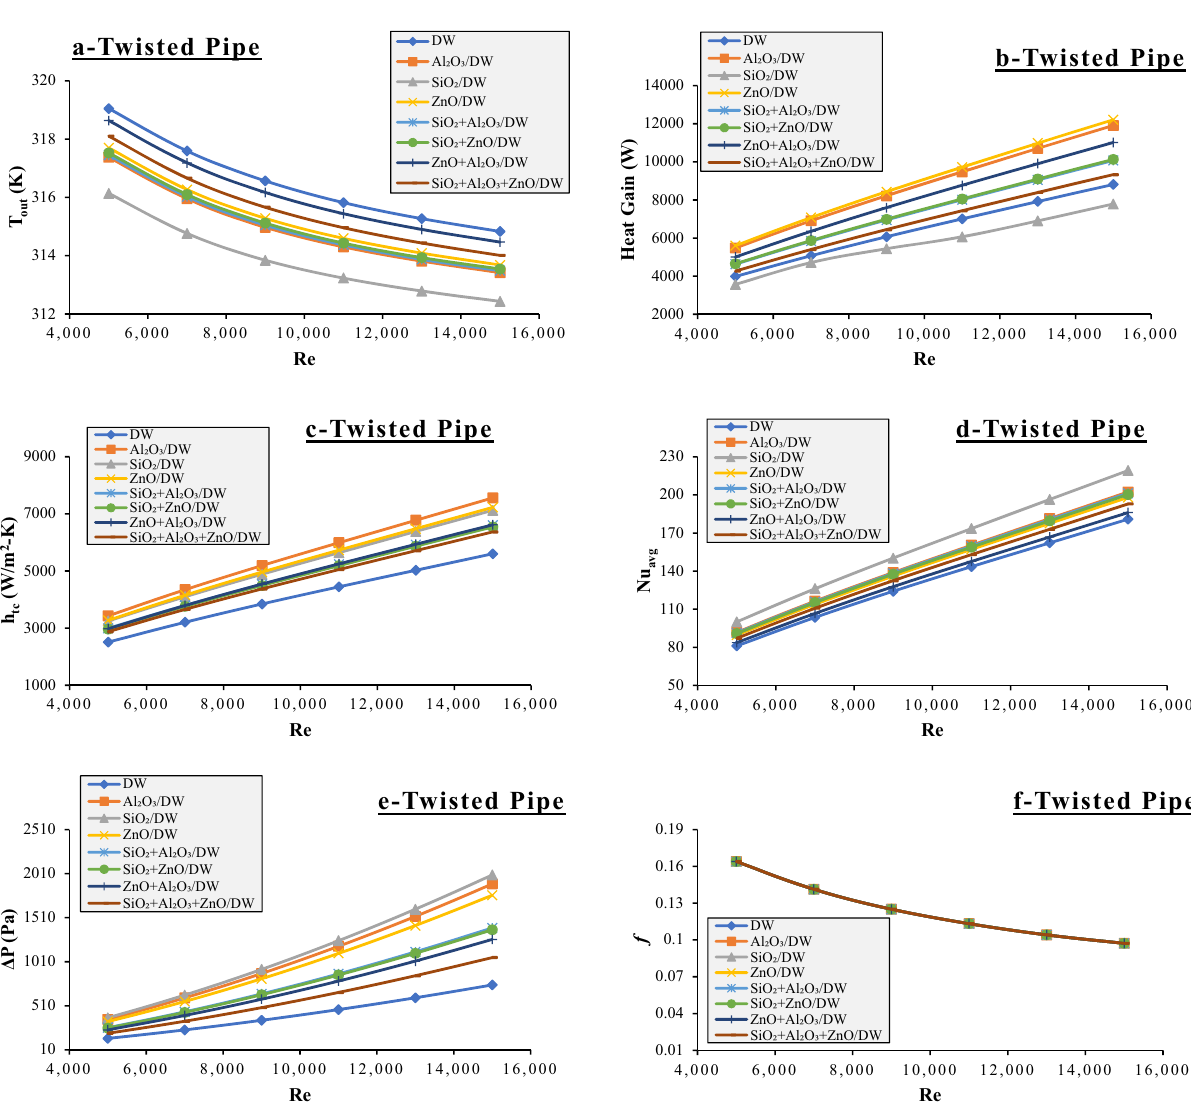
Figure 5: Thermohydraulic parameters of twisted pipe using DW, single, hybrid, and ternary nano fl uids: ( a ) outlet temperature, ( b ) heat gain, ( c ) heat transfer coe ffi cient, ( d ) average Nusselt number, ( e ) pressure loss, and ( f ) friction